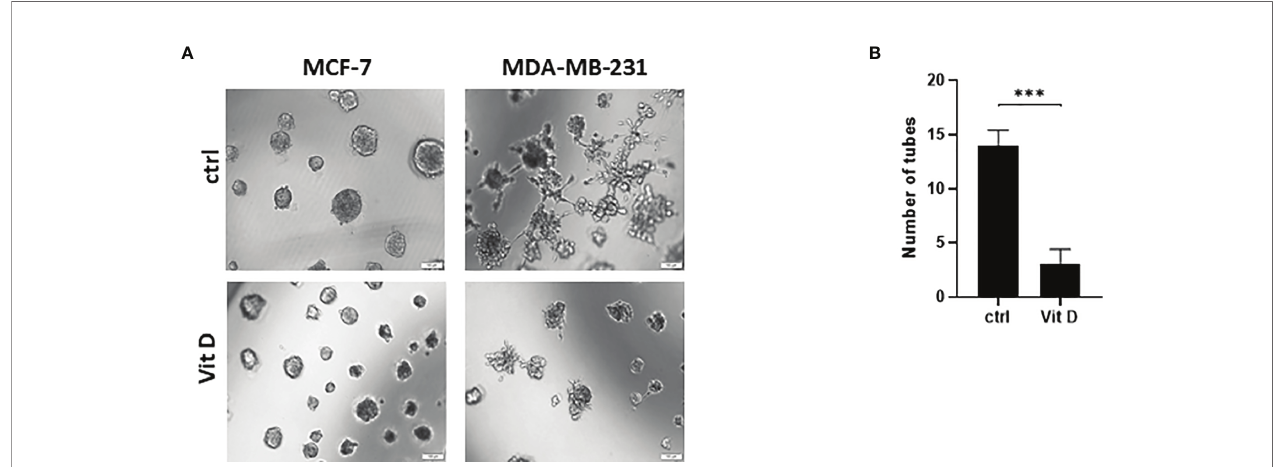
FIGURE 6 | The effect of calcitriol treatment on tube formation assay in MCF-7 and MDA-MB-231 cells after calcitriol treatment. (A) Reduction of the cell mass of both MCF-7 and MDA-MB-231 cells after treatment with calcitriol (10 µM). (B) Signi fi cant inhibition of tube formation in MDA-MB-231 cells after treatment with calcitriol. (***) represents statistically signi fi cant change ( p < 0.001) in number of cells between treated and control (Ctrl) untreated cells at given time